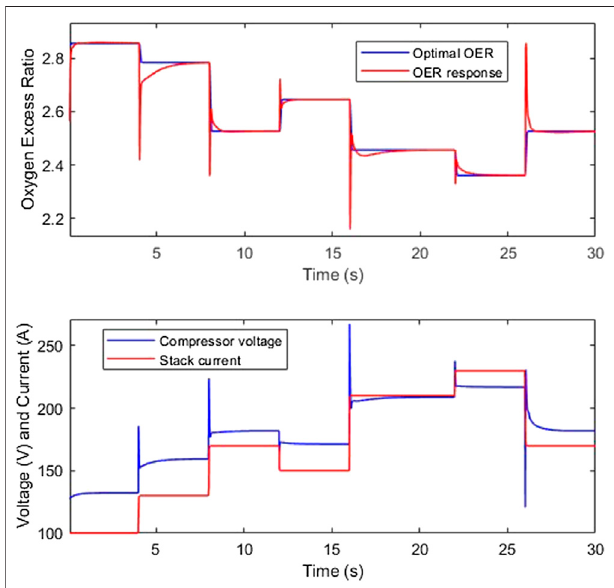
FIGURE 10 | Optimal OER adaptation at T st (cid:1) 80 ° C.